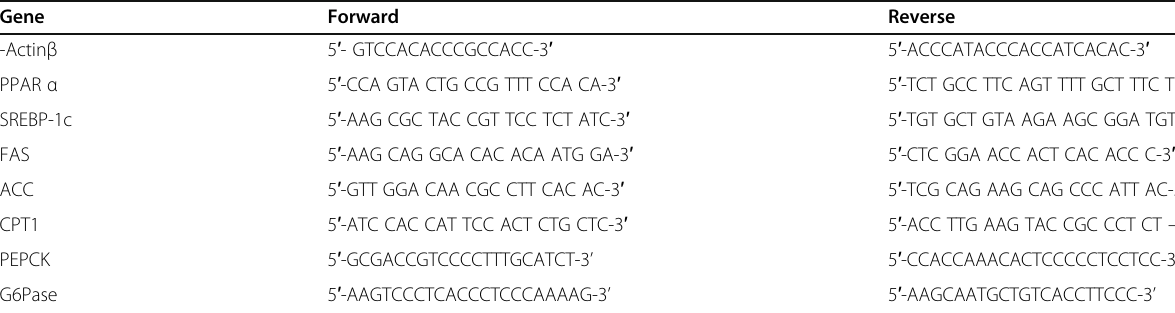
radical was 50% at a concentration of 4.36 mg/mL com- pared to the scavenging effects of GA at 0.016 mg/mL. Due to being at levels lower than its LOQs, the concen- tration of peak 7 assigned to Fer A was determined using the peak area of a single standard concentration at around the CCAE peak area for that compound using the formula: Marker compound content in mg = Mass in mg of the standard × Peak area of the sample (CCAE)/ Peak area of the standard. Experiment 1: selection of CCAE dosage using IPGTT According to IPGTT results, CCAE had a prompt (short-term) hypoglycemic effect in ET2D but not in LT2D; and the hypoglycemic potency of 90 mg/kg of CCAE was comparable to 100 mg/kg of metformin con- sistent with Mojaz Dalfardi et al. [44] (Supplement 1, Fig. S1A). We chose this dosage (90 mg/kg of CCAE) for the daily treatment of rats during the 28-day experiment. Experiment II. To show differences in metabolic disarray between ET2D and LT2D and to investigate the differential effects of daily usage of CCAE on sugar and fat metabolism after 28 days